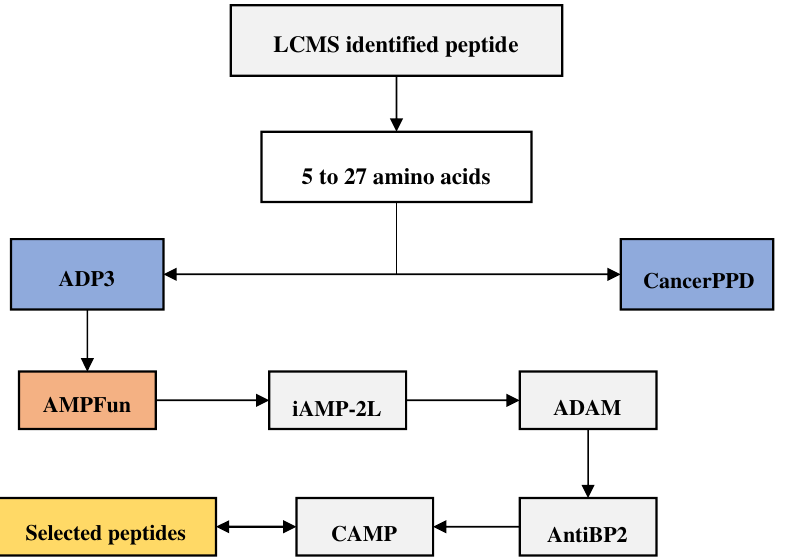
Figure 1. Workflow for bioinformatics prediction of antimicrobial peptides.